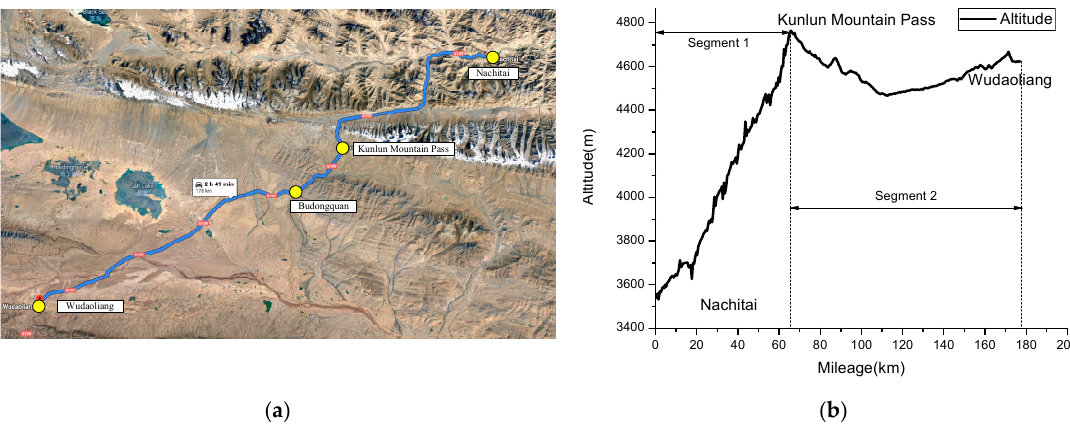
Figure 1. ( a ) Layout of the experimental route; and ( b ) altitudes along the experimental route.